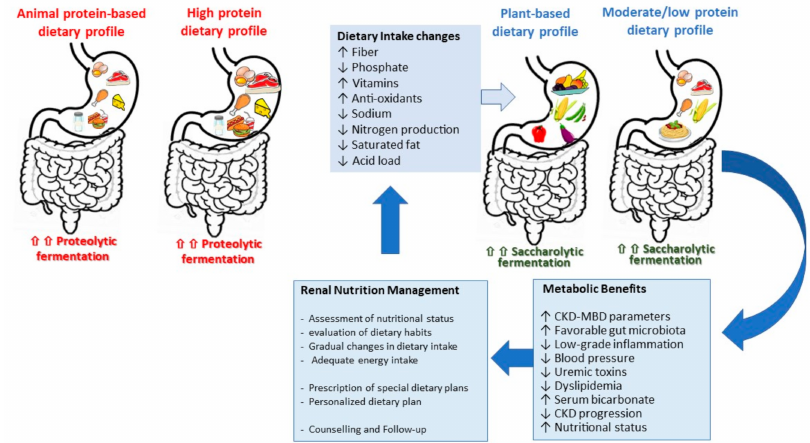
Figure 1. Renal nutritional management in chronic kidney disease (CKD) patients, on stages 3 to 5 not on dialysis: shifting from a high protein diet to a low protein and / or plant-based diet. CKD-MBD = Chronic kidney disease mineral and bone